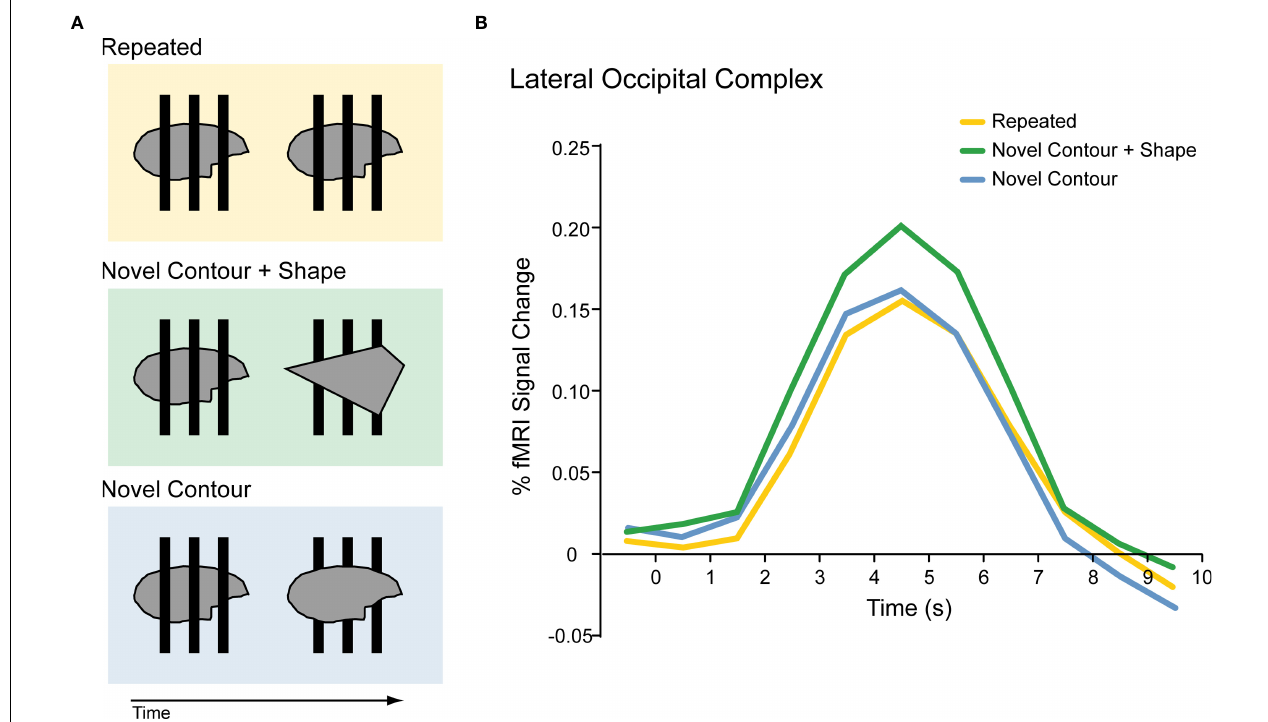
FIGURE 2 | An example of habituation in functional neuroimaging (adapted from Kourtzi and Kanwisher, 2001). (A) In each trial, two stimuli were presented sequentially (each for 300 ms with a 400 ms pause in between). The stimuli were simple shapes presented behind or in front of three partially occluding bars. In the Repeated trials, the same shape was repeated at the same depth with respect to the occluders. In the Novel Contour trials, the same shape was repeated, but moved in depth with respect to the occluders, such that the local visible contours changed. In the Novel Contour + Shape trials, a different shape was presented as the second